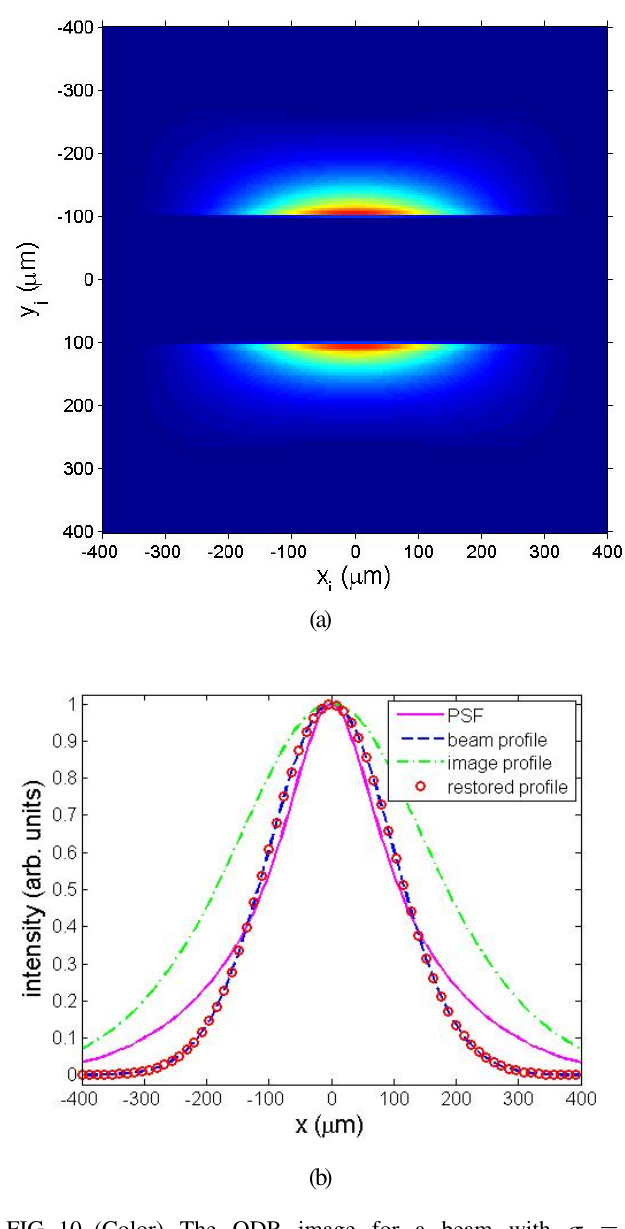
FIG. 10. (Color) The ODR image for a beam with (cid:9) 100 (cid:8) m (a); the projected 1D profile of the PSF, the beam, the image, and the restored beam from deconvolution (b).